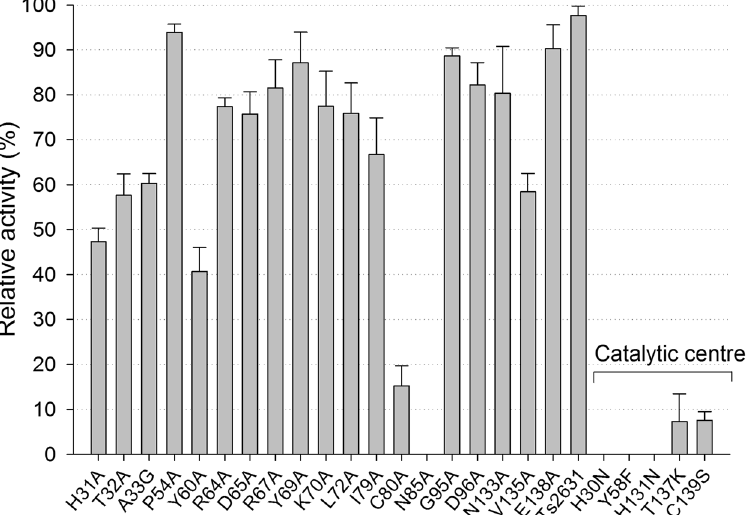
Figure 5. Lytic activity of Ts2631 endolysin mutants at 60 °C against chloroform-treated T. thermophilus HB8 substrate. Bacteriolytic activity was measured in a standard turbidity reduction assay in a 96-well plate format. Activities are expressed as percentages relative to the native Ts2631 endolysin activity. Mutations are identified by the one-letter code for the wild-type amino acid followed by the residue number and then the one-letter code for the mutant amino acid. Error bars indicate the standard deviation (n =